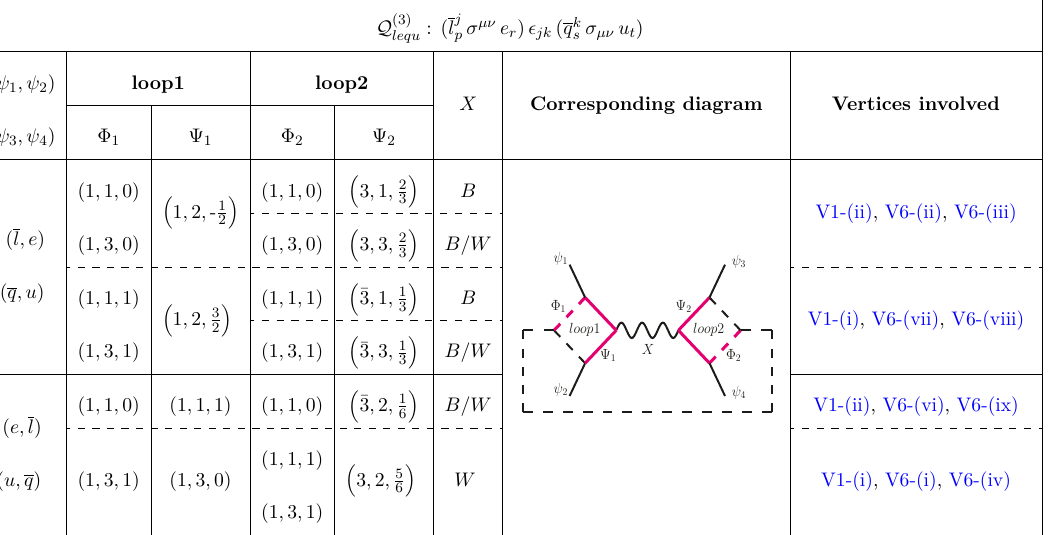
JHEP06(2021)033